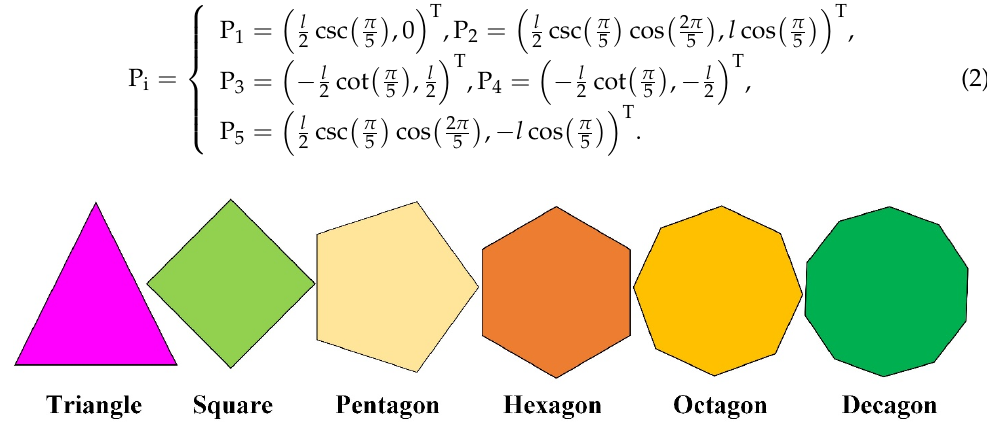
Figure 3. The geometric shapes of regular polygons with different number of